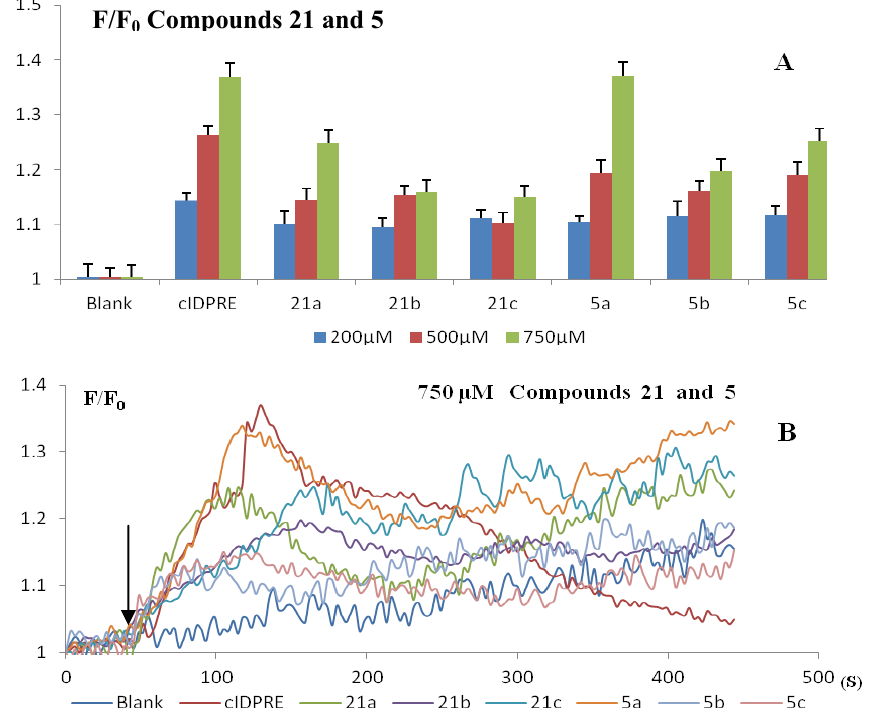
Figure 2. Ca 2+ mobilization activities of compounds 21 and 5 in intact Jurkat T